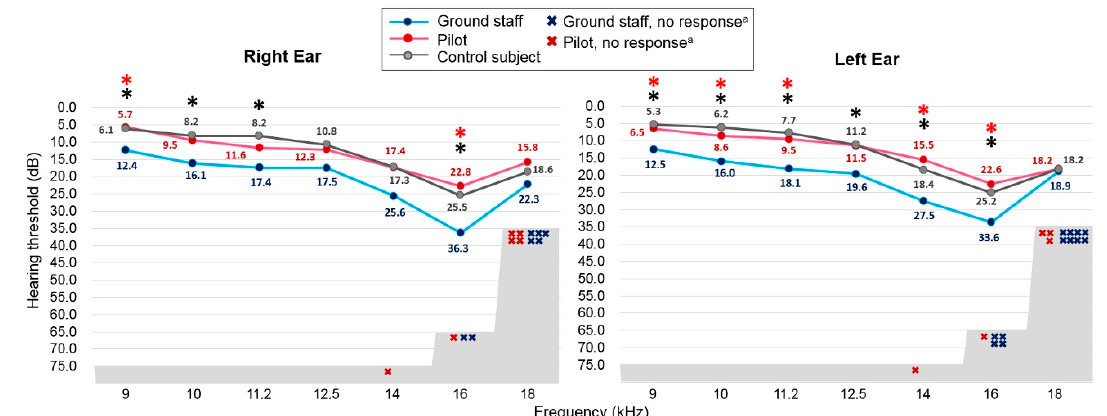
Figure 3. Average extended high-frequency thresholds measured from frequencies of 9–18 kHz in the ground staff and pilot groups. The value of each data point indicates the average thresholds across subjects at the corresponding frequency. Gray areas indicate the thresholds detected beyond the maximum output of the audiometer. Hearing thresholds that fell into a gray area were drawn with red “X” symbols for pilots and blue “X” symbols for ground staff. Comparisons between the groups were performed using the Kruskal—Wallis test, followed by Scheffe’s post-test. * black asterisk indicates p < 0.05 when comparing the ground staff with the control subjects. * red asterisk indicates p < 0.05 when comparing the ground staff group with the pilot group.